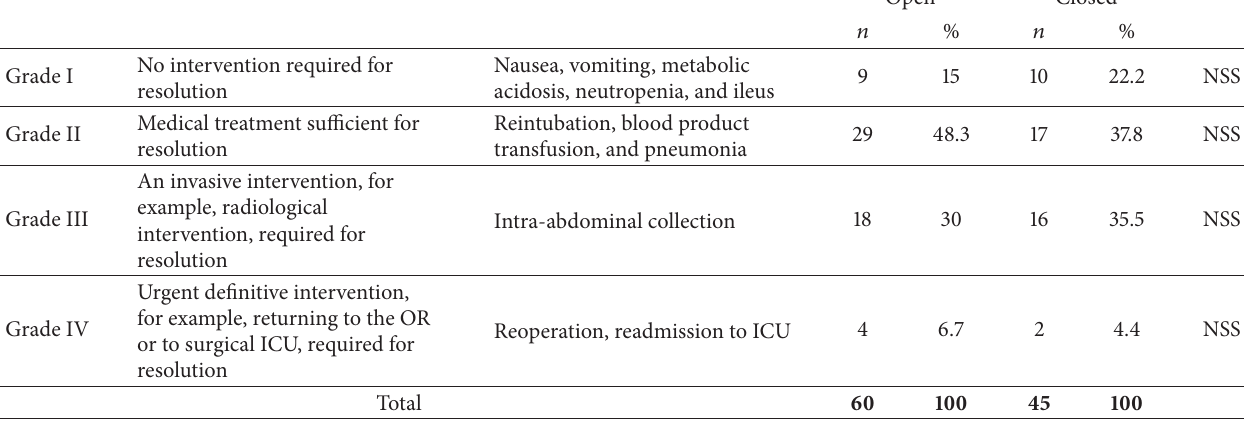
Table 3: Complications.